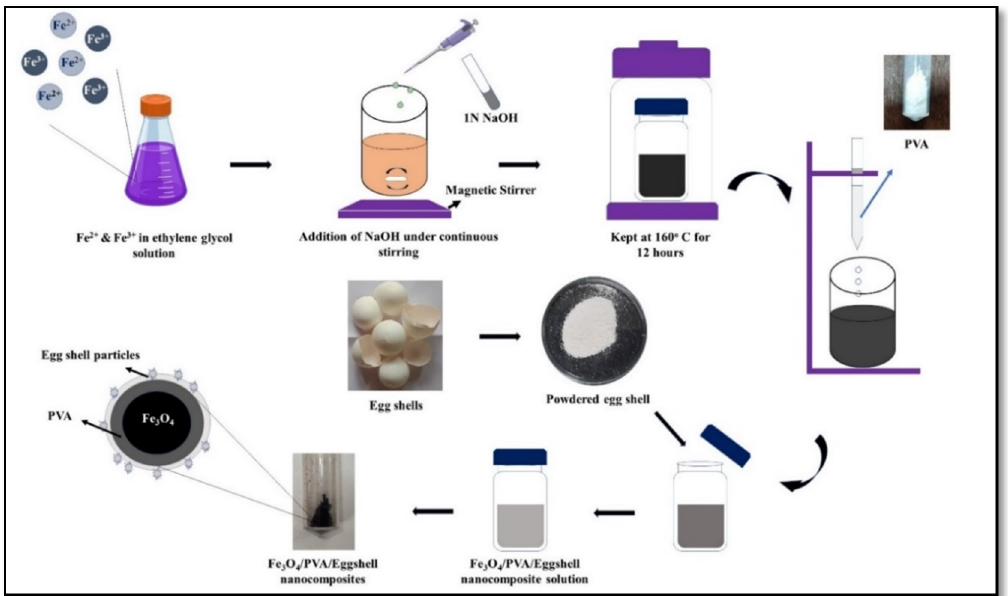
Figure 1. Key steps for the synthesis of Fe 3 O 4 /PVA/eggshell hybrid nanocomposite.